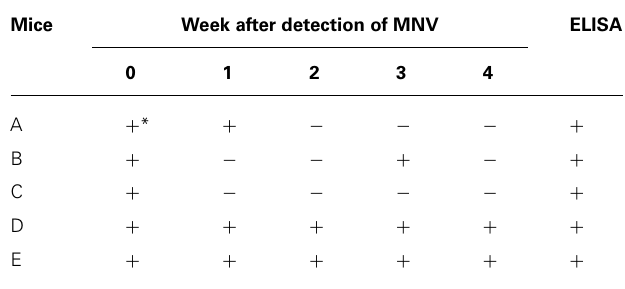
*RT-PCR positive.